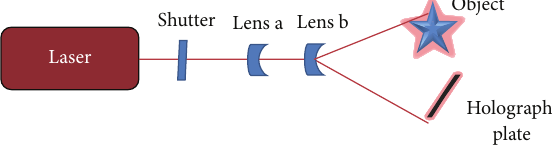
Figure 1: Off-axis single beam setup.